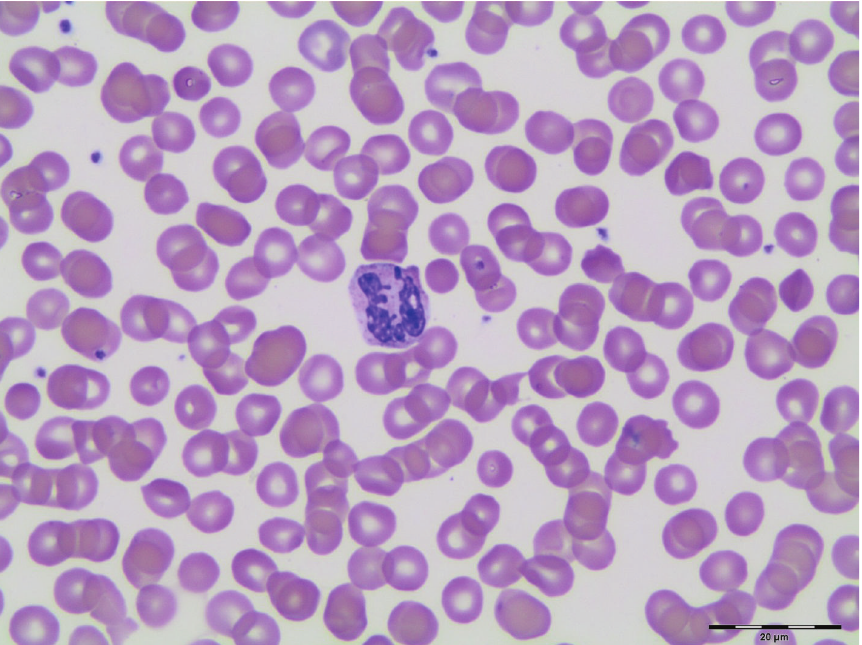
Figure 1: A neutrophil with aberrant thin, rod-shaped, spike-shaped, and pedunculated nuclear projections (Wright Giemsa stain, 100x oil).